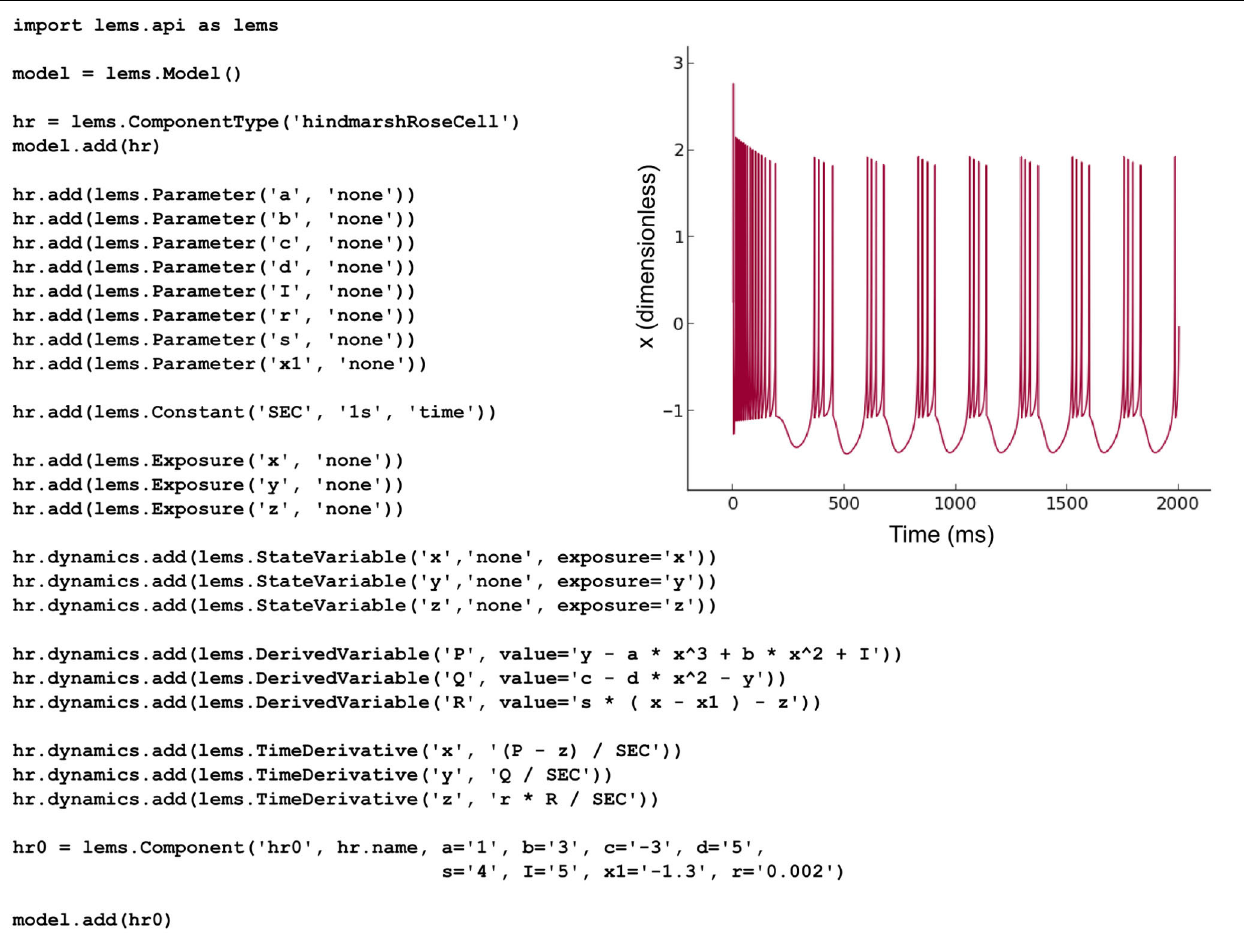
with a particular set of parameters is created. This Python script produces valid LEMS XML which can be used by any LEMS-compliant simulator to simulate the model. The inset shows the behavior of the state variable x (corresponding to the model neuron’s membrane potential) when the model is executed in